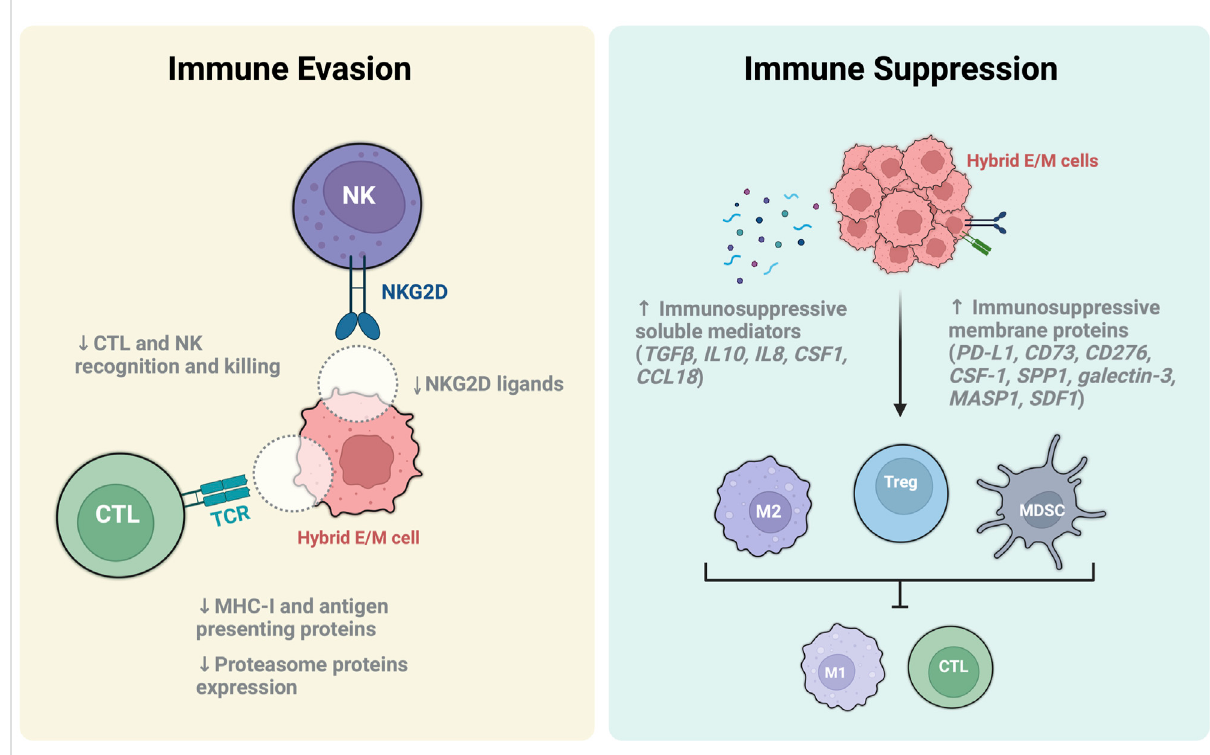
FIGURE 4 Immune escapeandimmune suppressionmechanismsofhybridE/M cells.ImmuneevasionisamechanismtherebyhybridE/M cellscanelude immune surveillance and killing by cytotoxic T lymphocyte (CTL) and Natural killer cells (NK). The main mechanisms involved include the downregulation of T cell receptor (TCR) and NKG2D ligands on hybrid E/M cell surface, the inhibition of the antigen presenting machinery and proteasome protein expression (light yellow box). On the other hand, hybrid E/M cells perform the immune suppression by increasing the release of immunosuppressive soluble mediators, upregulating the expression of immunosuppressive membrane proteins and inducing the differentiation of immune cells toward their immunosuppressive phenotypes such as anti-in fl ammatory M2 macrophages, regulatory T cells (Treg) and myeloid-derived suppressor cells (MDSC) (light blue box). These cells, in turn, have the ability to damp the immune response by inhibiting the activation of immune stimulatory cells (e.g., M1 macrophages, CTL), thus promoting the formation of an immunosuppressive